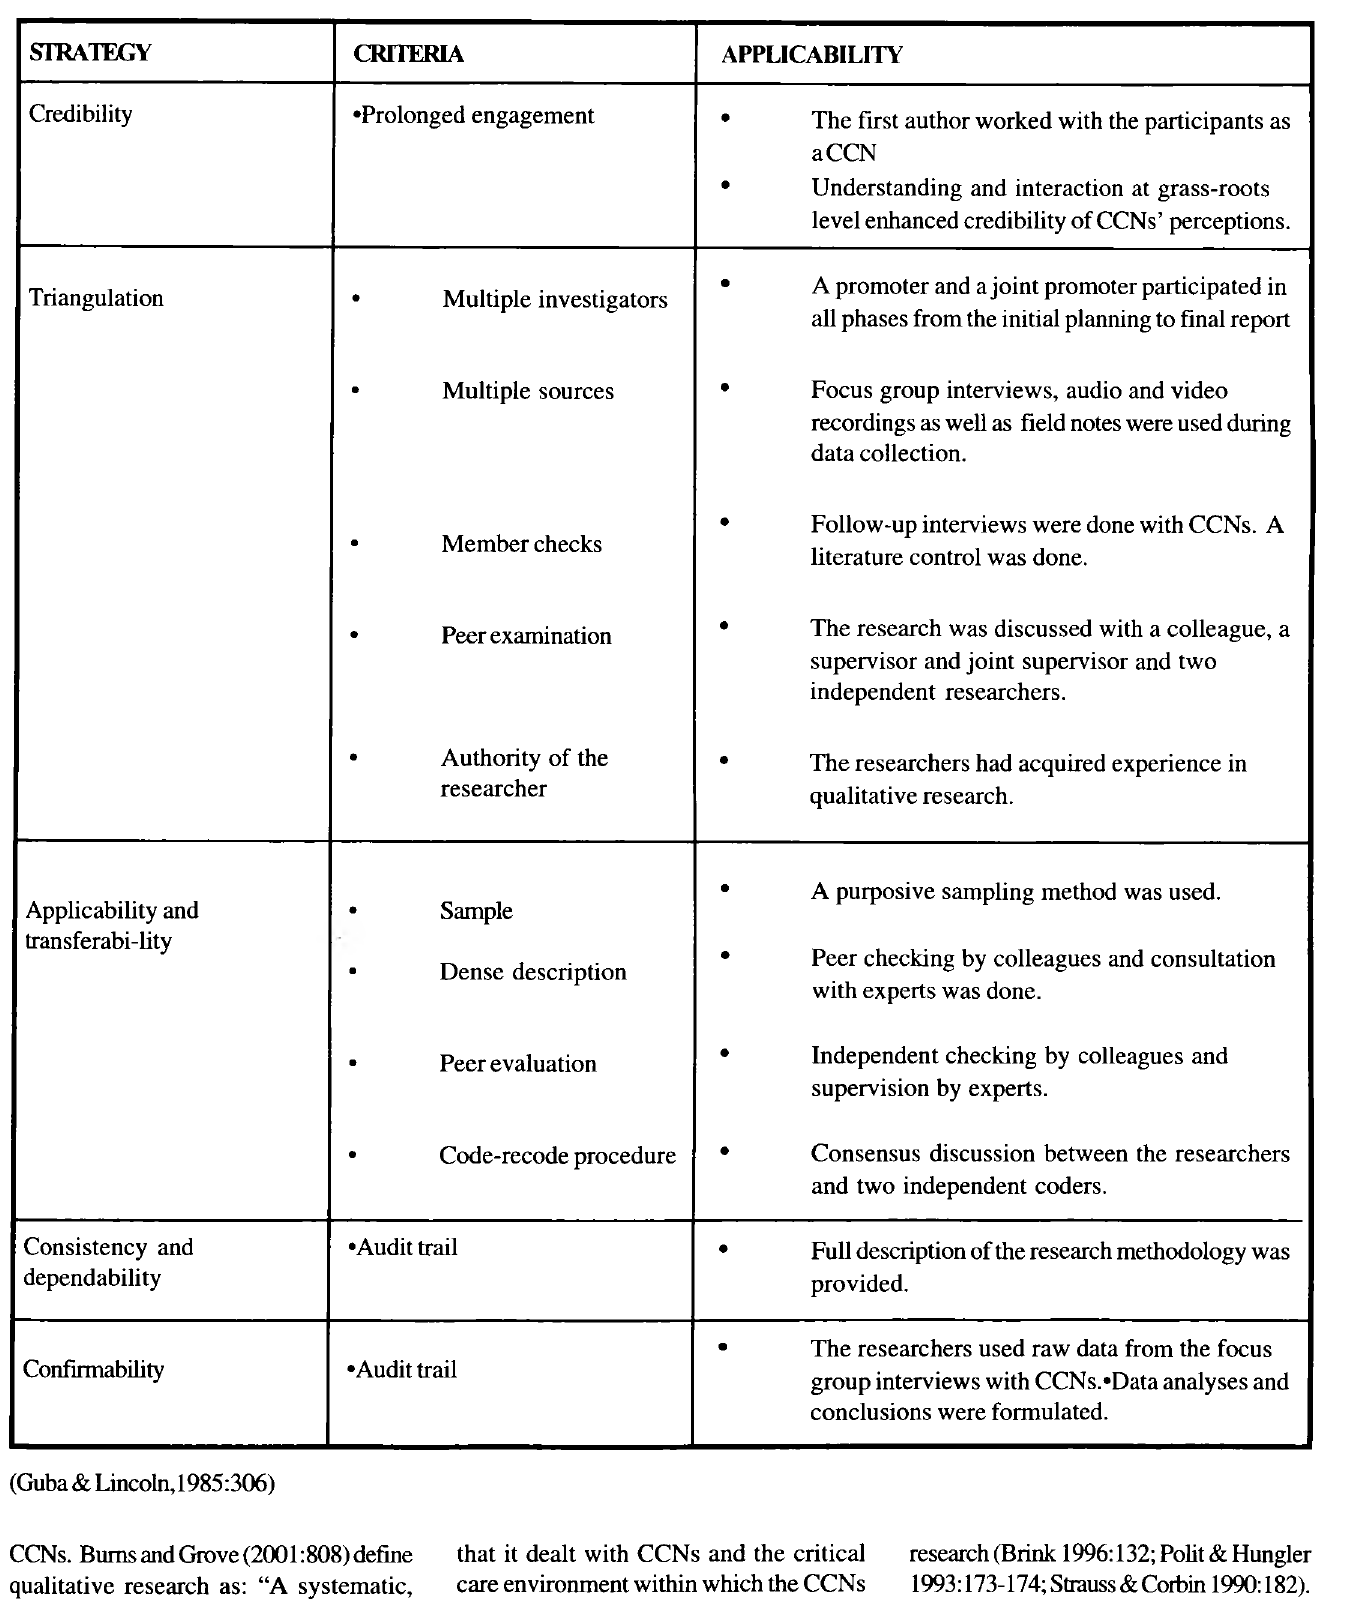
Tablel: Measures for ensuring trustworthiness